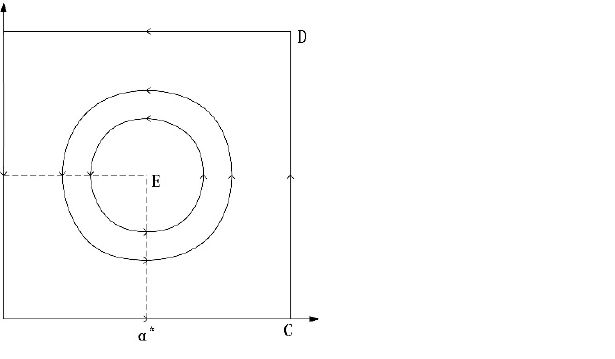
Figure 2. Scenario 2 evolutionary path between local government and coal-related enterprises.